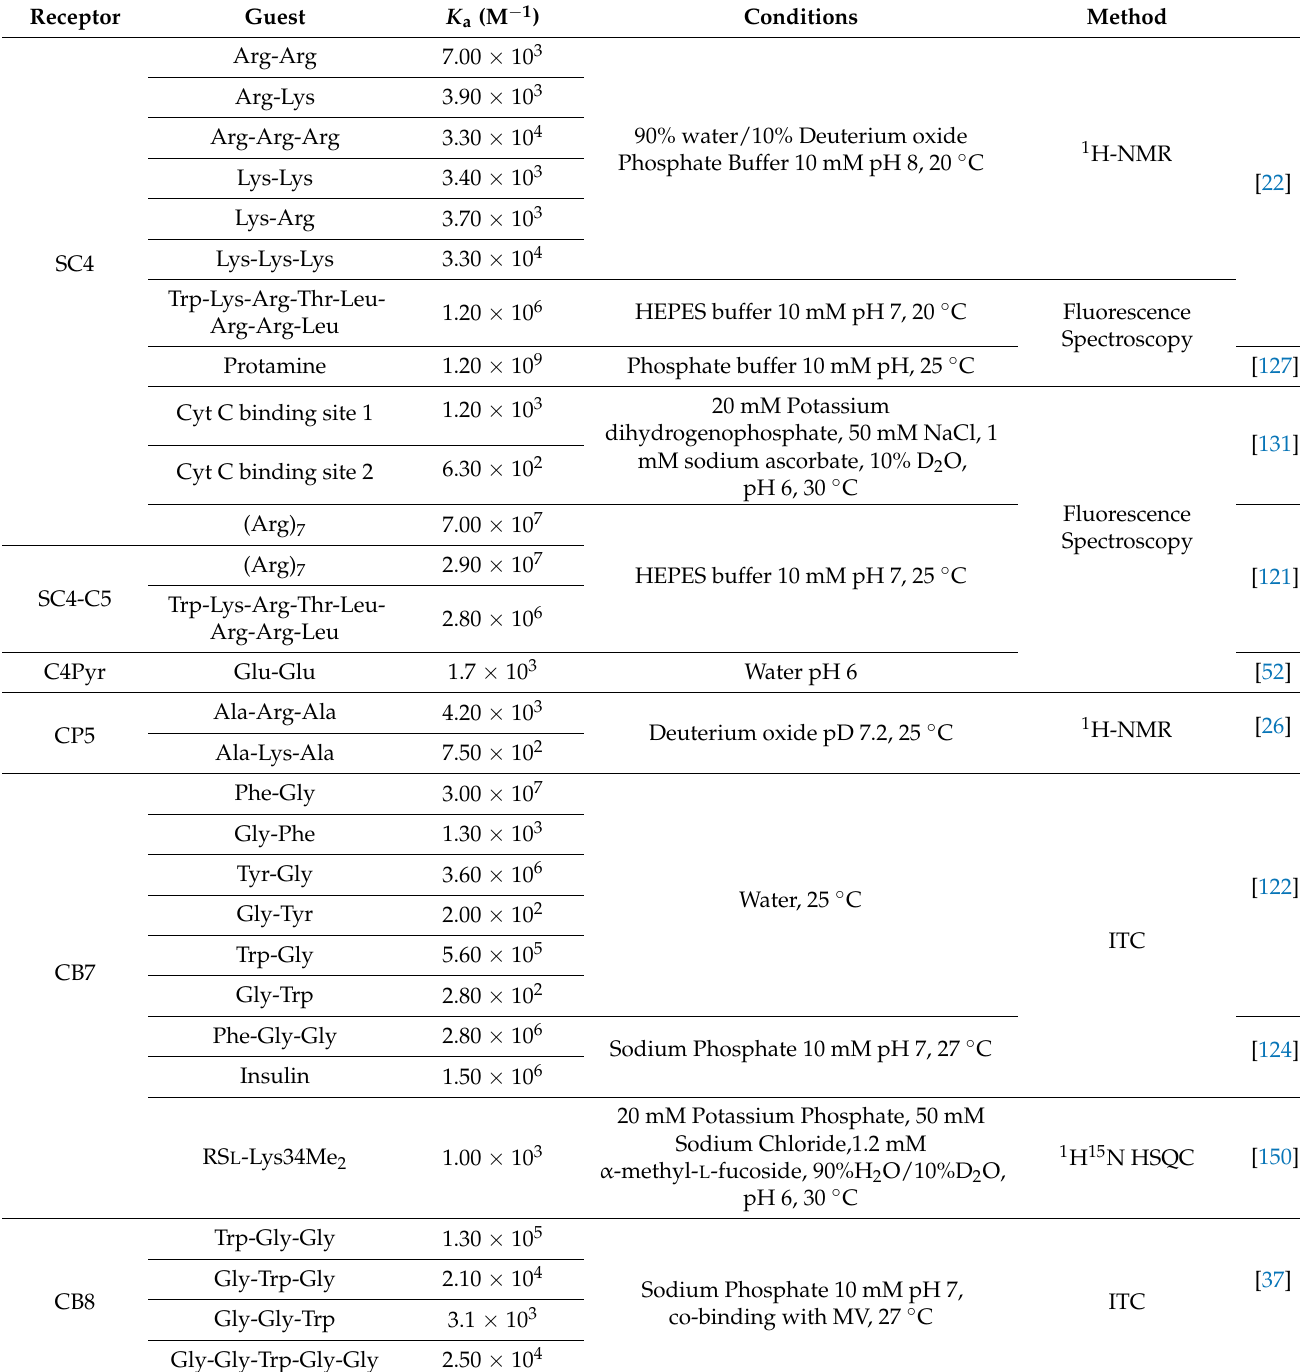
Table 2. Binding constants ( K a ) for the formation of host-guest complexes between small peptides and synthetic supramolecular